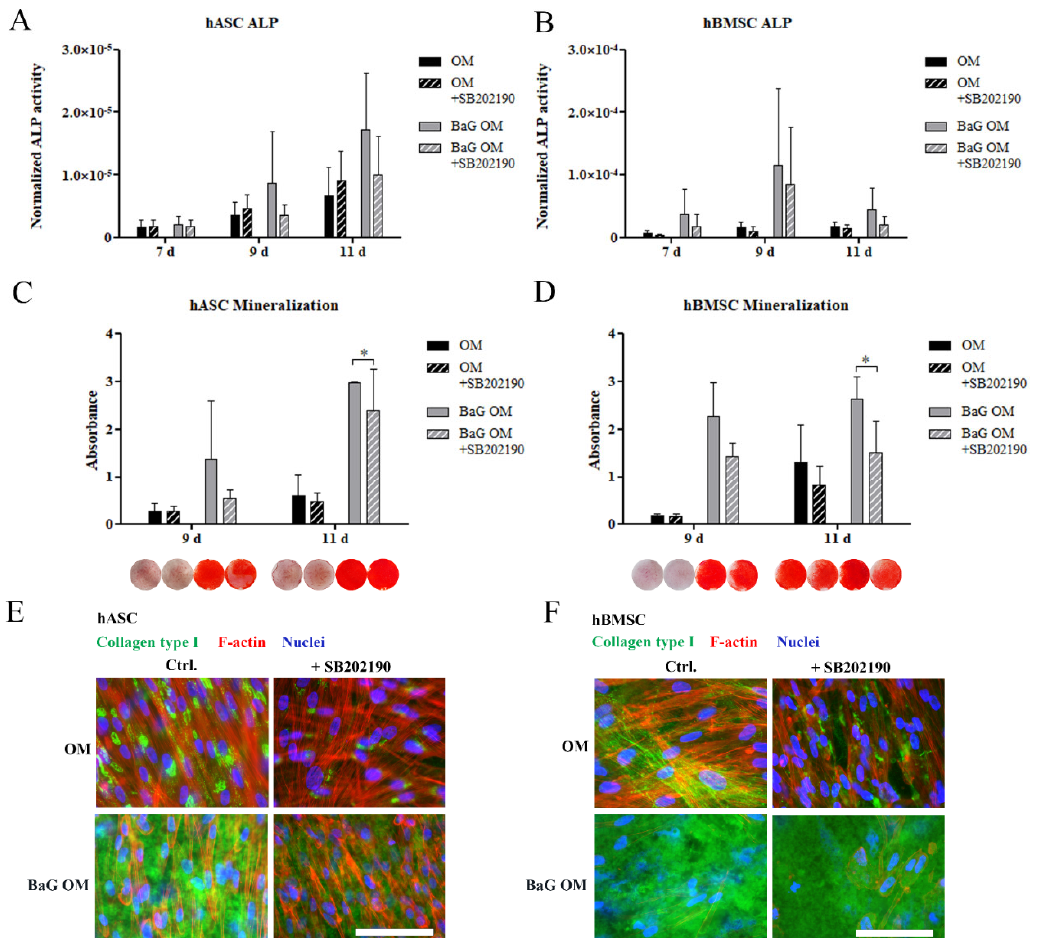
Figure 3. The effect of p38 MAPK inhibition with SB202190 on hASC and hBMSC osteogenesis. hASCs and hBMSCs were cultured in BM, BaG BM, OM, and BaG OM supplemented with 3 µ M SB202190 inhibitor. ( A , B ) Early osteogenic differentiation was assessed with ALP activity. ( C , D ) Matrix mineralization was analyzed with Alizarin Red staining (stained wells, area 1.9 cm 2 ). ( E , F ) ICC staining of collagen type I. Scale bars are 100 µ m. Values for OM and BaG OM conditions without the inhibitor, and qualitative representative results of Alizarin Red staining are the same as presented in Figure 1. Statistical analysis: ALP analysis (and cell proliferation used to normalize the ALP activity data); N = 9, independent biological replicates of three donors of each cell type. Mineralization; hASCs: N = 9 independent biological replicates of three donors; hBMSCs: N = 6 independent biological replicates of two donors. Statistical analysis was conducted within the time point, and comparisons were made between OM and OM + SB202190 or BaG OM and BAG OM + SB202190. * p ˂ 0.05. Abbreviations: osteogenic medium, OM; and bioactive glass, BaG.